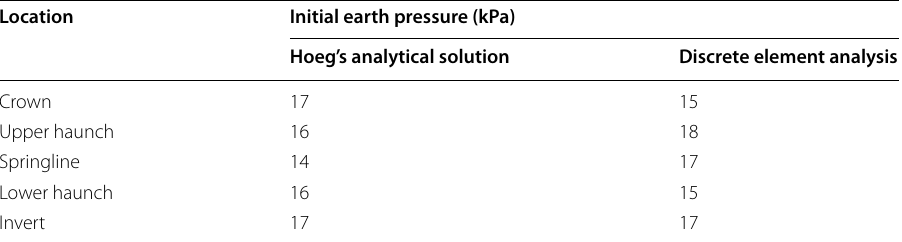
Table 3 Comparison of calculated pressures with analytical